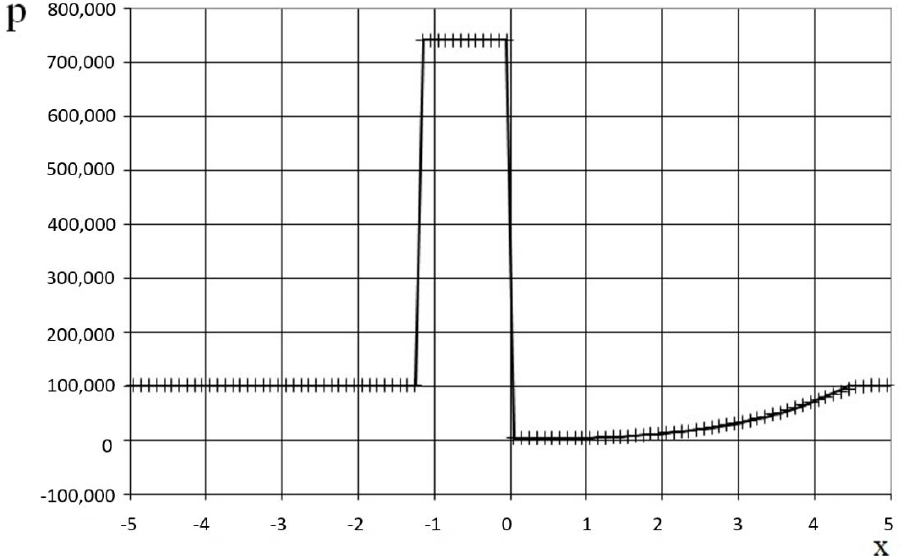
Figure 30. Velocity plot for the problem (54): the exact solution (line), and the present method (cross).